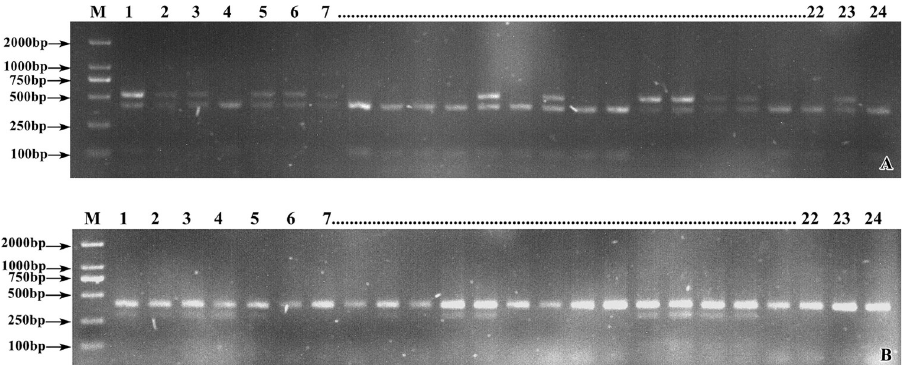
Fig 6. Enzymatic results marked in partial tetraploid and strains. (A) chr2-CAPS6 enzyme digestion electrophoresis. (B) chr2-CAPS21 enzyme digestion electrophoresis. M. DL2000 Marker; 1–24. Tetraploid varieties and